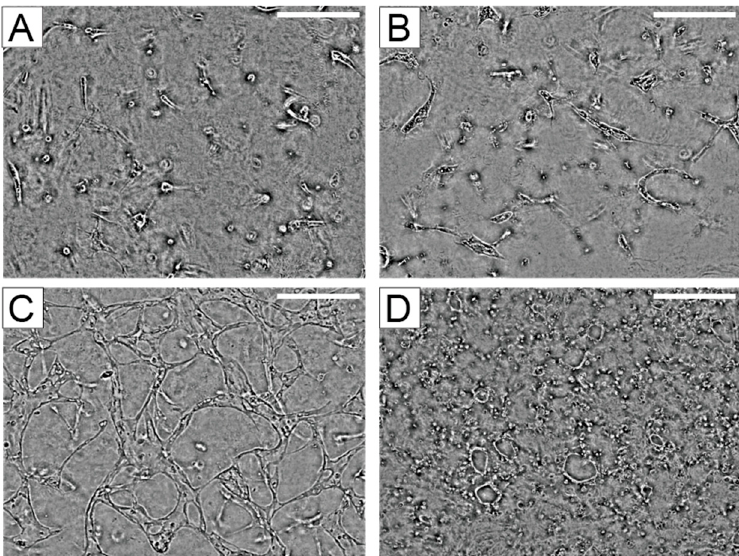
Figure 3. The vascular network formation depends on the number of cells seeded on a cell culture well in the device: ( A ) 0.5 × 10 5 cells/well; ( B ) 1.0 × 10 5 cells/well; ( C ) 2.0 × 10 5 cells/well; ( D ) 2.5 × 10 5 cells/well. All images were taken at 72 h of culture. Scale bar = 150 µm.